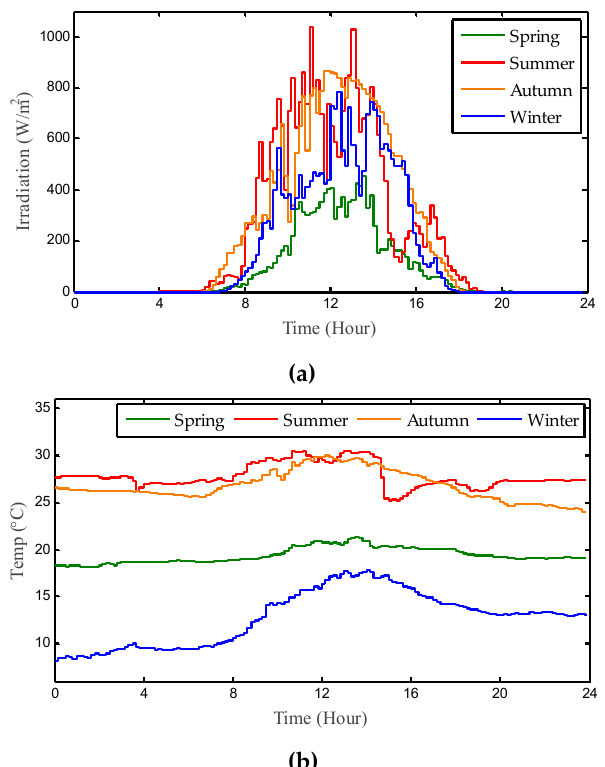
Figure 10. Daily profile of solar irradiation and temperature in Hong Kong. ( a ) Irradiation; ( b ) Temperature.